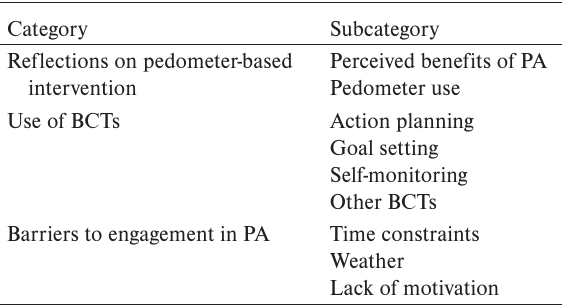
Category Subcategory Reflections on